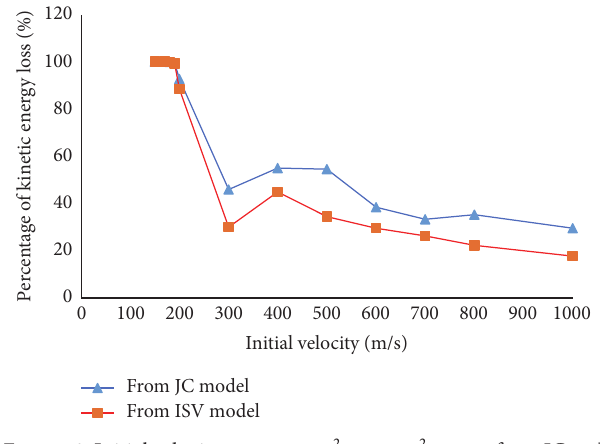
Figure 8: Initial velocity versus V initial 2 − V residual 2 curves from JC and ISV